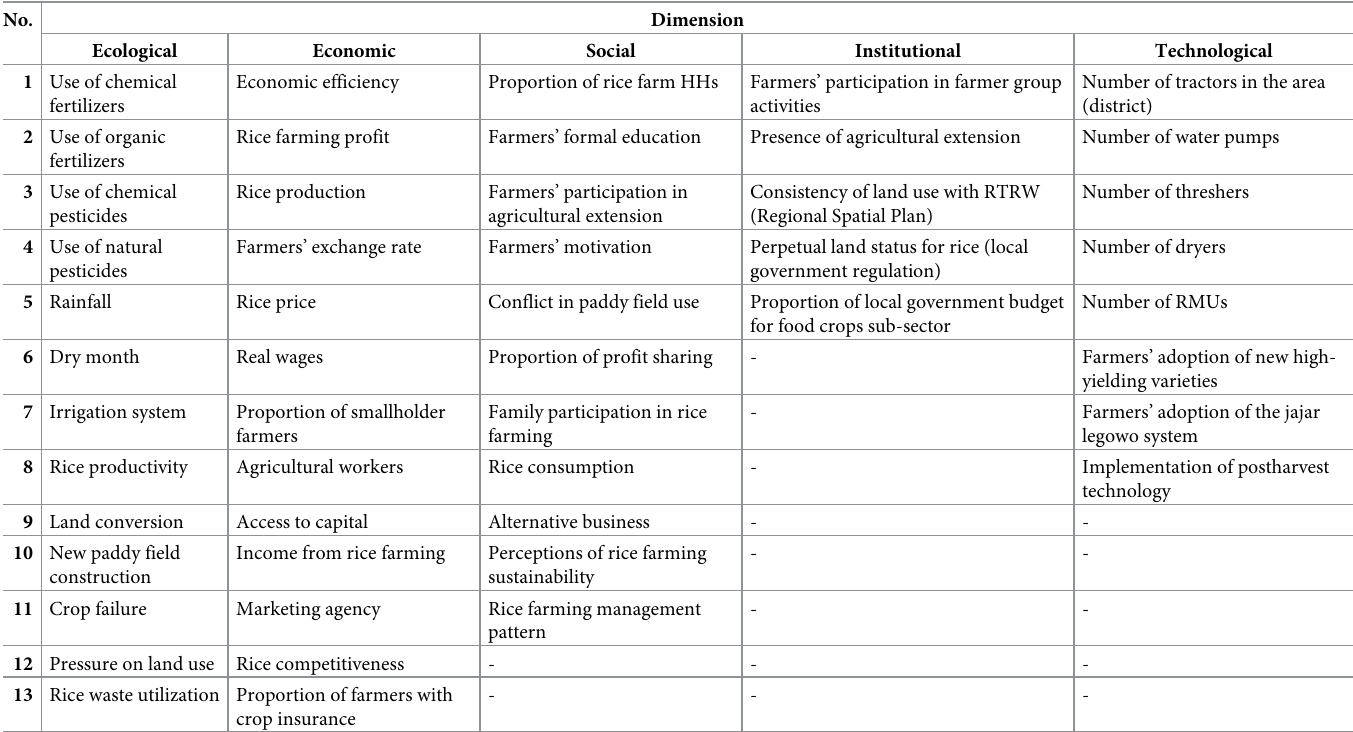
Table 1. Dimensions and attributes used in